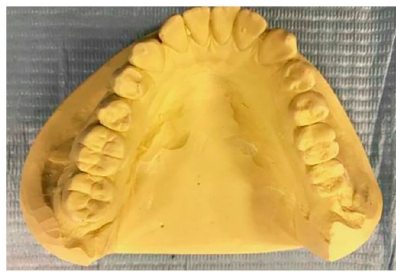
Figure 3. Example of a dental stone model [31]. Published by Elsevier.